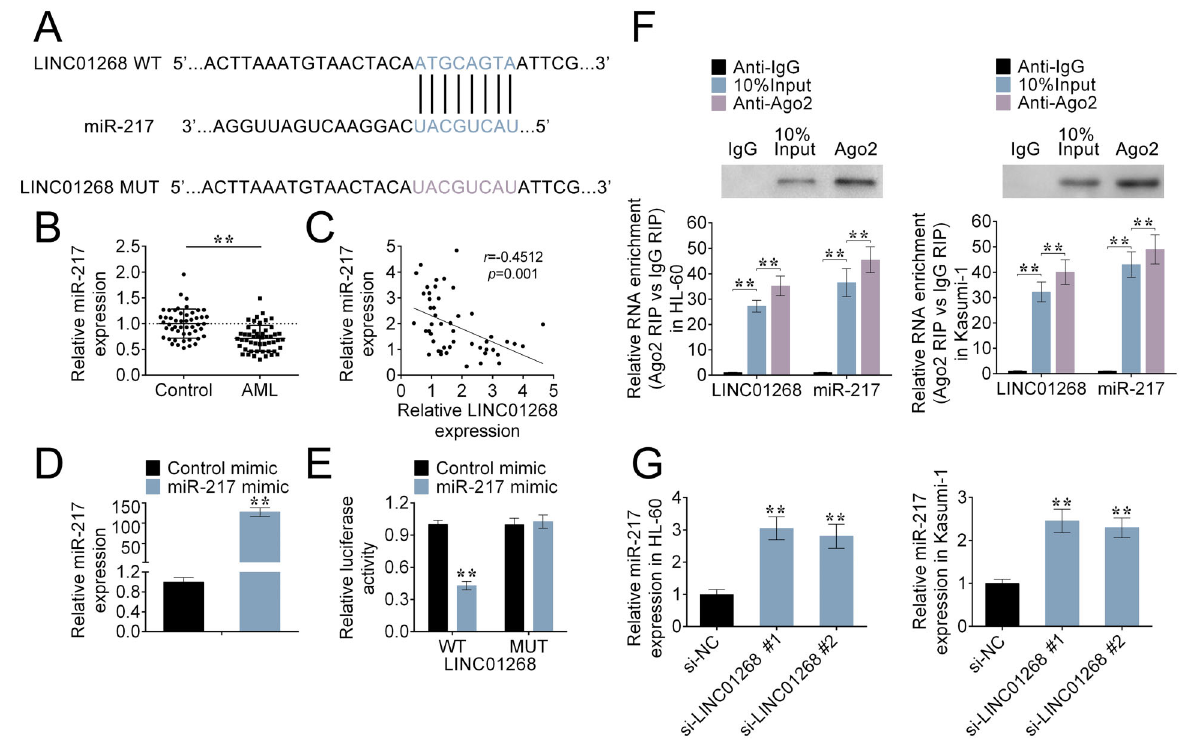
Figure 3. LINC01268 acting as a sponge of miR-217. A , The potential targeted miRNA for LINC01268 was identi fi ed by the miRDB website. B , The expression of miR-217 in bone marrow tissues from acute myeloid leukemia (AML) patients and healthy donors (control) was evaluated by qRT-PCR. C , The correlation between LINC01268 and miR-217 was evaluated by the Pearson correlation analysis. D , The expression of miR-217 in AML cells transfected with miR-217 mimic was detected by qRT-PCR. E , The luciferase activity of the reporter with LINC01268 wild type (WT) or mutated (MUT) was evaluated by the luciferase reporter assay. F , RIP assay demonstrated that miR-217 and LINC01268 were greatly enriched in the Ago2 antibody group. G , The binding relationship between miR-217 and LINC01268 was further con fi rmed by RIP assay. Data are reported as means ± SD. **P o 0.01 vs the control group (ANOVA and t -test). NC: